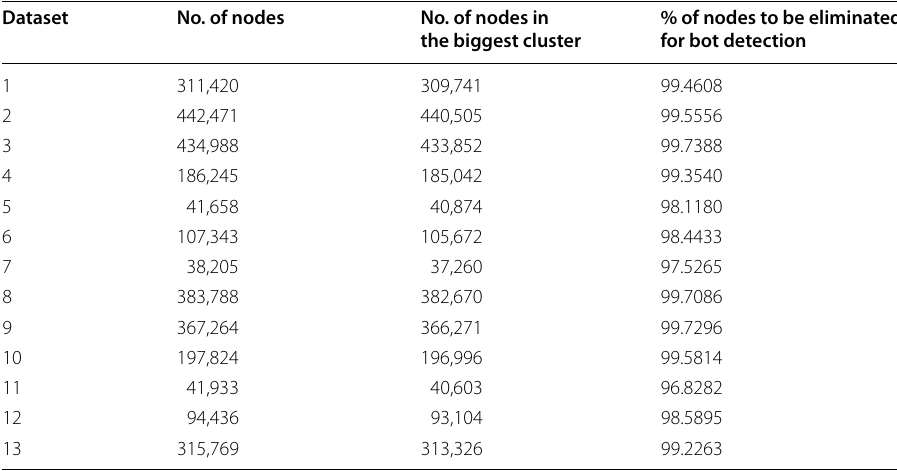
Table 3 Number of nodes in the biggest cluster (normal nodes) Dataset